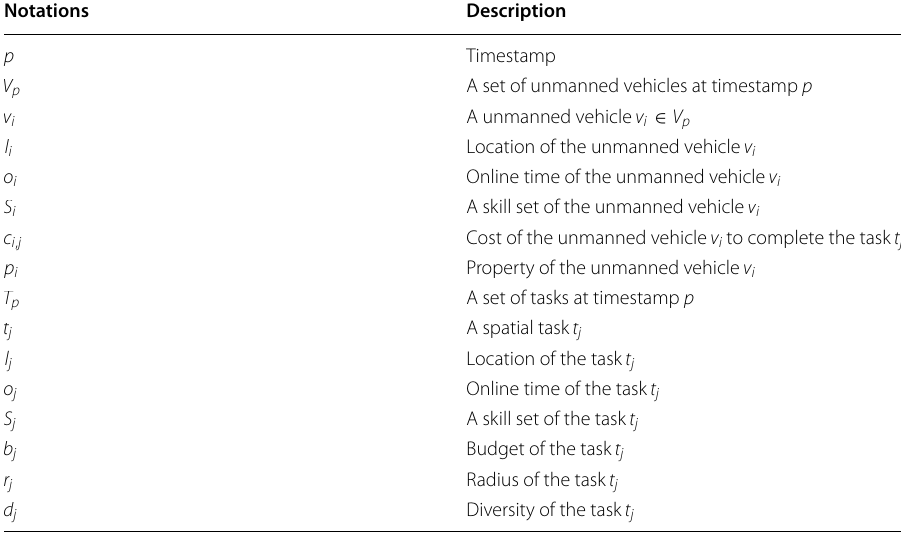
Table 3 Summary of notations